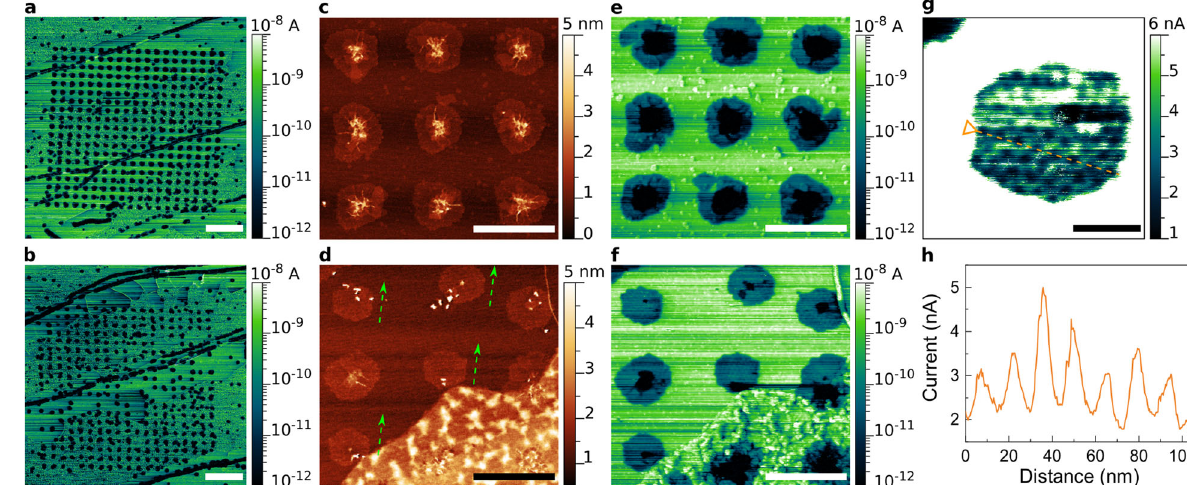
Fig. 3 SAvdWE of h-BN at IIDs written with varying number of He ions. cAFM images of areas with 19 × 19 overgrown IIDs in a distance of 250 nm to each other, written with ( a ) 40,000 and ( b ) 10,000 He ions per IID. A bias of 100 mV was applied to graphene during the measurements. c – f Detailed AFM images of h-BN islands forming close to a step edge on BLG patterned with ( c ) 40,000 and ( d ) 10,000 He ions per IID with corresponding cAFM images at a bias of 200 mV in ( e ) and ( f ), respectively. The green dashed arrows in ( d ) act as a guide to they eye depicting the common orientation among the hexagonal-shaped h-BN islands. g cAFM image of a single h-BN island with linear current scale. h Pro fi le along orange dotted line in ( g ) demonstrates a Moiré pattern of ~14 nm in the conductivity, evidencing an epitaxial alignment between the island and the EG. Scale bars, 2 μ m in ( a ) and ( b ), 250 nm in ( c – f ), 50 nm in ( g